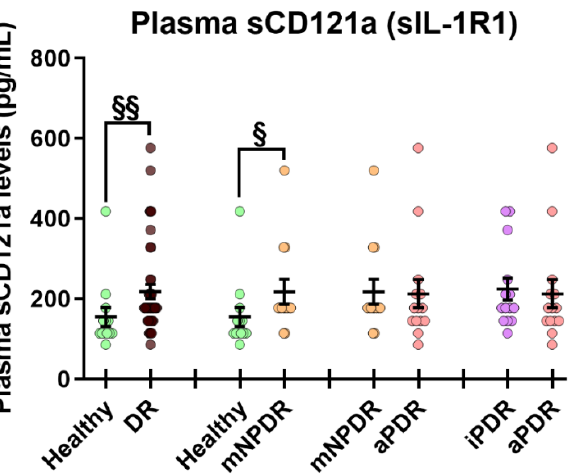
Figure 2. sCD121a (sIL-1R1) expression in plasma of DR patients and controls. Results are presented as mean ± SEM. n = 13–14 per group except DR where n = 41. § p < 0.05, §§ p < 0.01 in Mann–Whitney U test.